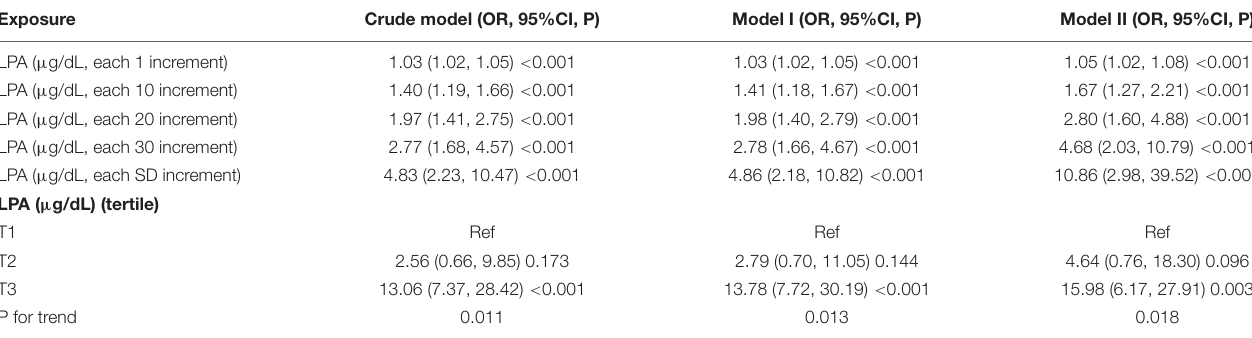
Crude Model adjusted for none. Model I adjusted for age and gender. Model II adjusted for age, gender, hypertension, diabetes, Marfan syndrome, COPD, medication history of aspirin, Stanford type, WBC, LPA, and management. COPD, chronic obstructive pulmonary disease; WBC, white blood cell; LPA, lysophosphatidic